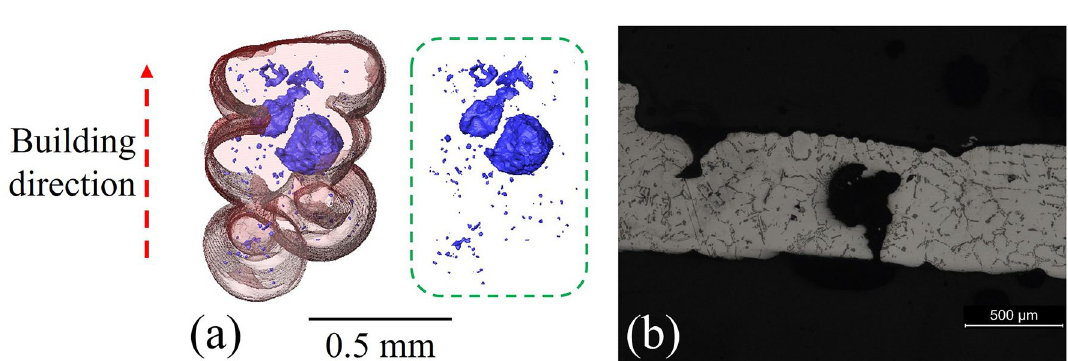
Figure 4. Magnified views of the larger defects found in some horizontal ribs: ( a ) X-ray μCT (Avizo Standard segmentation) and ( b ) optical (~ 26 ± 15 µm) defects may be observed in ~ 12% of horizontal ribs arising from the meeting of two melt fronts. Due to the low permeability of the plaster mold, it is suggested that this defect could be addressed by increasing the vacuum pressure; 3. The microstructure of the cast samples shows grains with both globular/dendritic morphologies. The grain size (73 ± 39 μm) does not significantly change in the different areas of the periodic cells, suggesting that